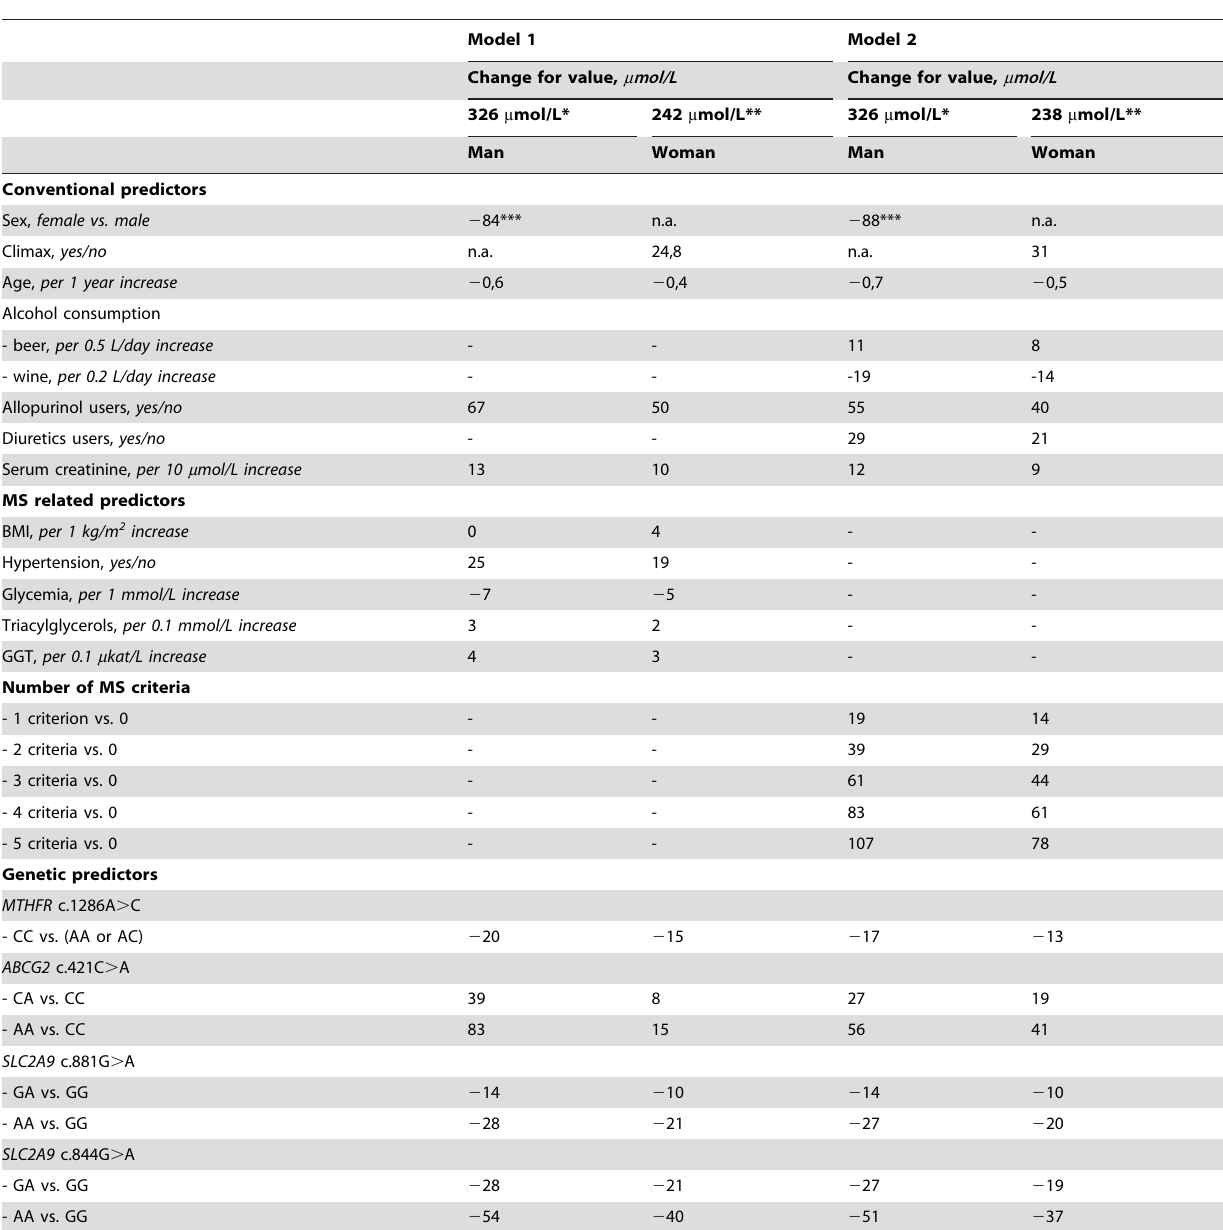
Table 3. Estimate of the effects of different predictors on the serum UA